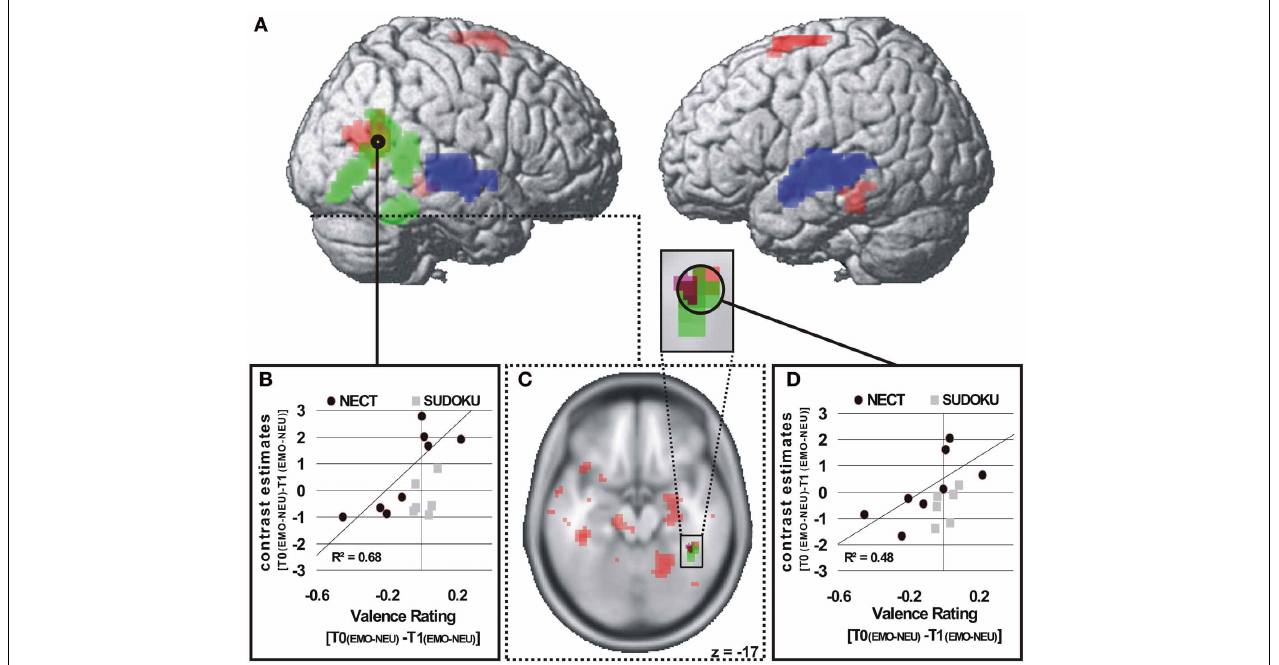
FIGURE 3 | Brain regions with a NECT-specific association between changes in behavioral ratings and cerebral responses (A,C). p < 0 . 01 (A) , p < 0 . 05 (B) , uncorrected, k ≥ 20 voxels (A) . Significant positive association of changes in behavioral emotion-sensitivity (T0 [ EMO − NEU ] − T1 [ EMO − NEU ] ) and changes in cerebral responses